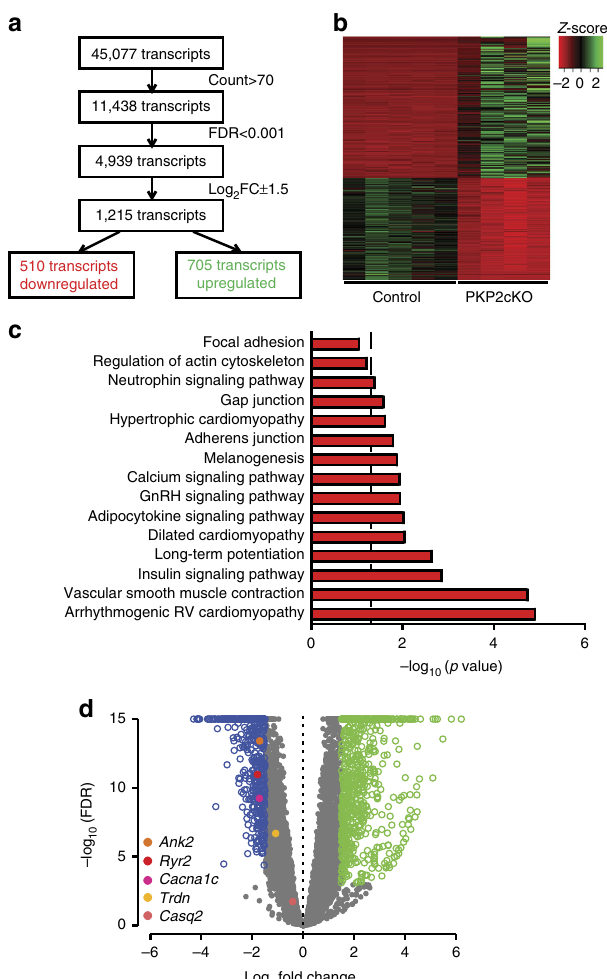
Fig. 3 Transcriptome analysis in PKP2-cKO and control mice. a Flowchart of RNA-Seq analysis. b Heatmap of transcripts from control and PKP2-cKO hearts at 21 dpi ( n = 5 and n = 4, respectively) highlighting consistency within groups. Red and green : downregulated and upregulated transcripts, respectively. c Signi fi cantly enriched KEGG (Kyoto Encyclopedia Genes and Genomes) categories show differentially downregulated gene pathways in PKP2-cKO hearts. d Volcano plot of upregulated ( green ) or downregulated ( blue ) transcripts in PKP2-cKO hearts as per inclusion criteria noted in a . Dots in gray : transcripts meeting exclusion criteria. Dots in other colors: speci fi c transcripts noted in bottom left of